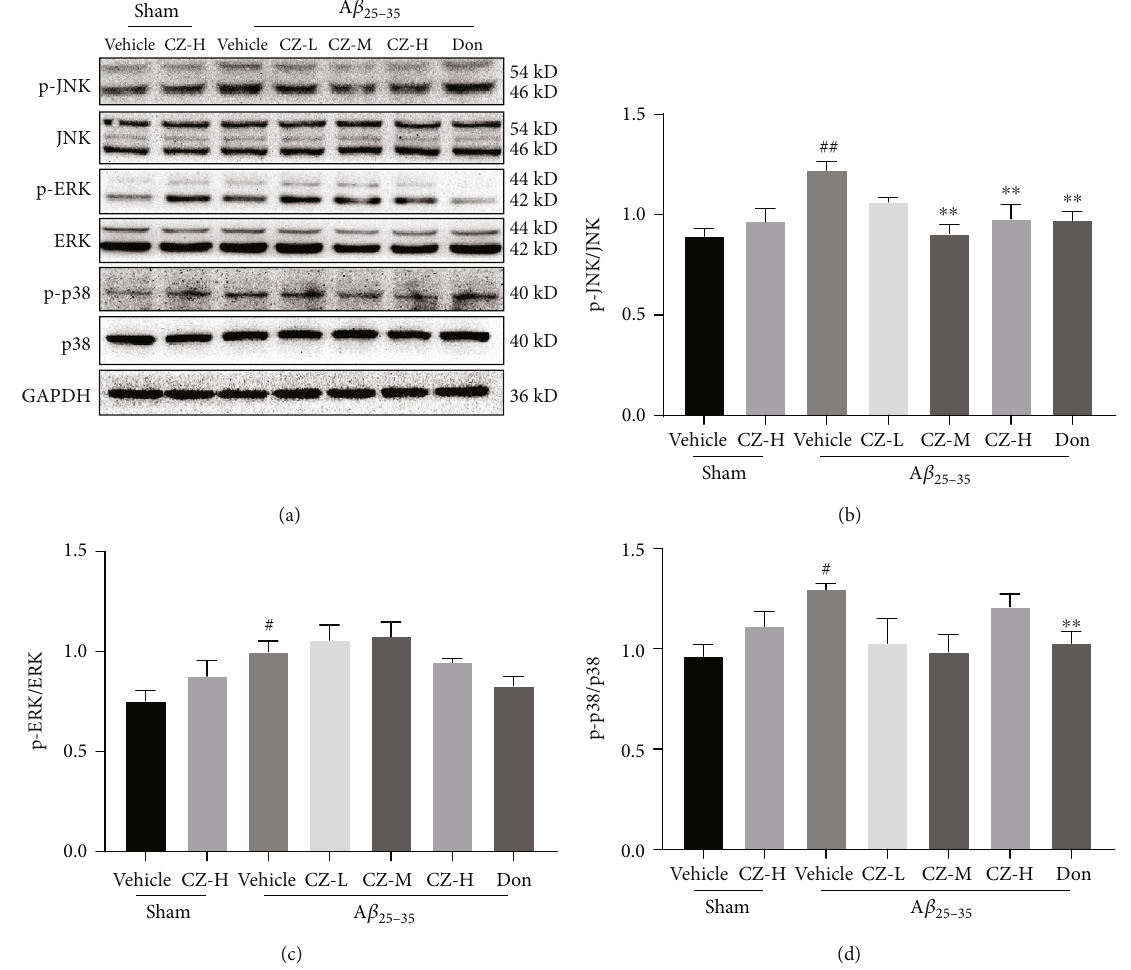
Figure 6: CZYH attenuates JNK phosphorylation induced by A β ERK, ERK, p-p38, and p38. (b – d) Statistics of (b) JNK, (c) ERK, and (d) p38 phosphorylation. Values are means ± SEM , n = 5 for JNK and ERK and n = 3 for p38. # P < 0 : 05 and ## P < 0 : 01 vs. sham; ∗ P < 0 : 05 and ∗∗ P < 0 : 01 vs. A β